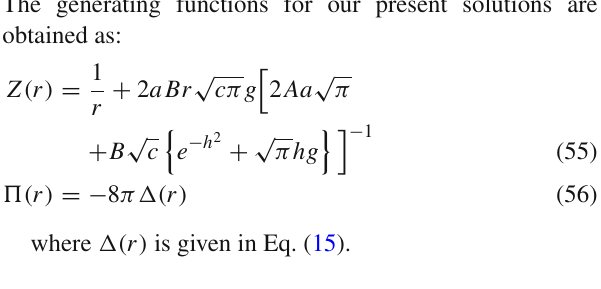
Fig. 11 Mass vs the central density ρ c corresponding to numerical values of constants given in Table 2 for four well-known compact stars